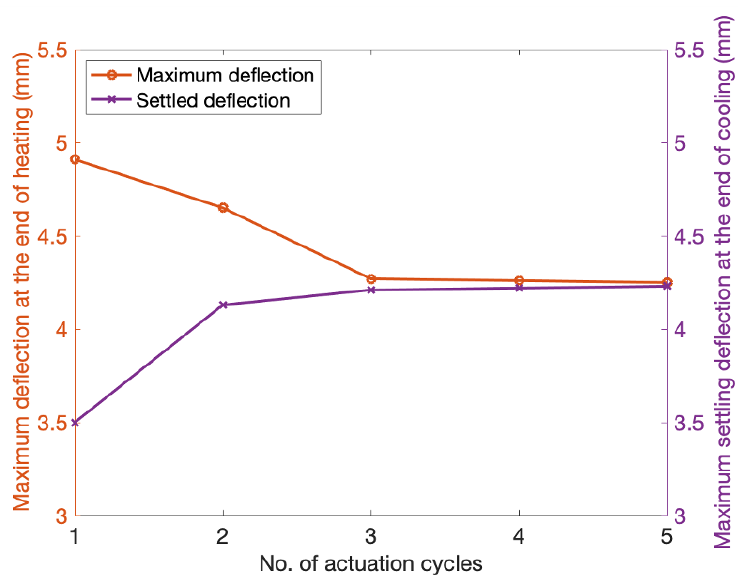
Figure 11. Maximum deflection of the SMC obtained during the heating process (red) and settled deflection of the SMC after the cooling process (purple) obtained for 5 periodic actuation cycles (from the COMSOL